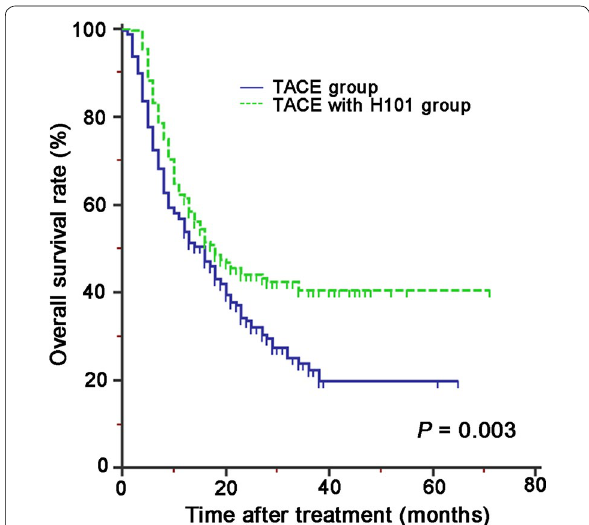
Fig. 1 Overall survival (OS) curves estimated by the Kaplan–Meier method for patients with intermediate to advanced hepatocellular carcinoma (HCC) who were treated with transarterial chemoemboli‑ zation (TACE) with or without